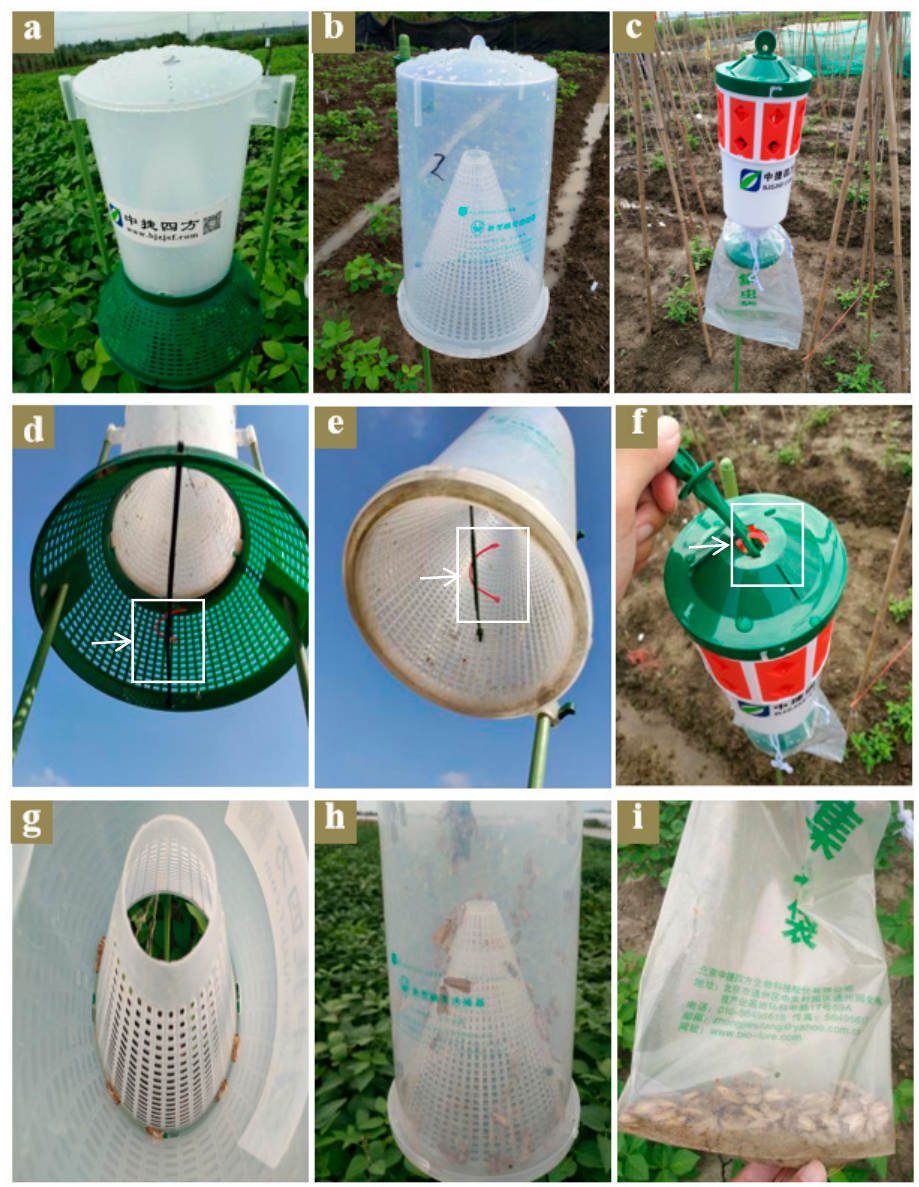
Figure 1. Three kinds of conventional traps, installation positions of pheromone lure and their insect collection devices. ( a ) Trap YL-HEMT; ( b ) Trap YL-NMT; ( c ) Trap YL-VT; ( d – f ) Pheromone lure installation device and location (indicated by the white box and arrow in the figure) of traps YL-HEMT, YL-NMT and YL-VT, respectively; ( g – i ) Insect collection devices of trap YL-HEMT, YL-NMT, YL-VT and captured males of S. litura . In ( a , c , f ), these Chinese characters represent the name of the manufacturer. In ( i ), these large Chinese characters represent insect collection devices of trap